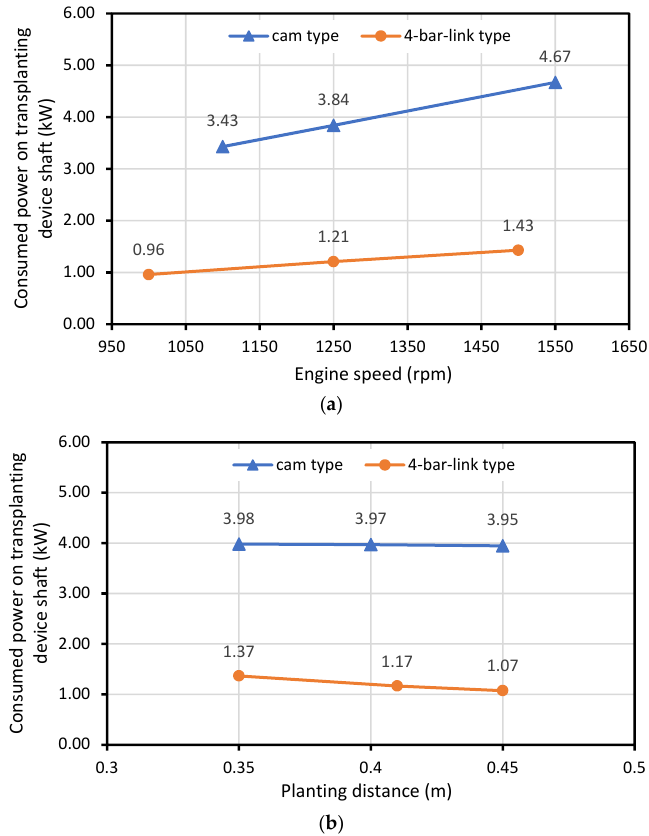
Figure 14. Comparison of consumed powers on transplanting device input shafts between cam and four-bar-link types according to working conditions: ( a ) engine speed and ( b ) planting distance.